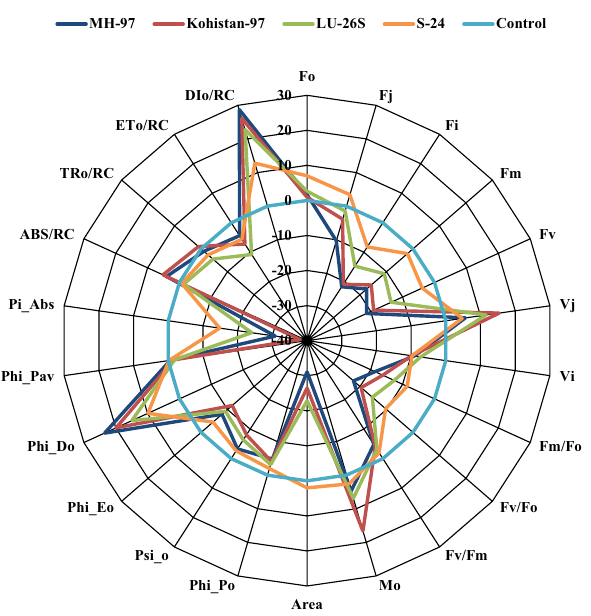
Figure 5. Radar plot of selected JIP test parameters showing changes in chlorophyll a fluorescence transients (normalized to 0 mM NaCl as reference) of four selected wheat cultivars subjected to 150 mM NaCl stress at vegetative stage.